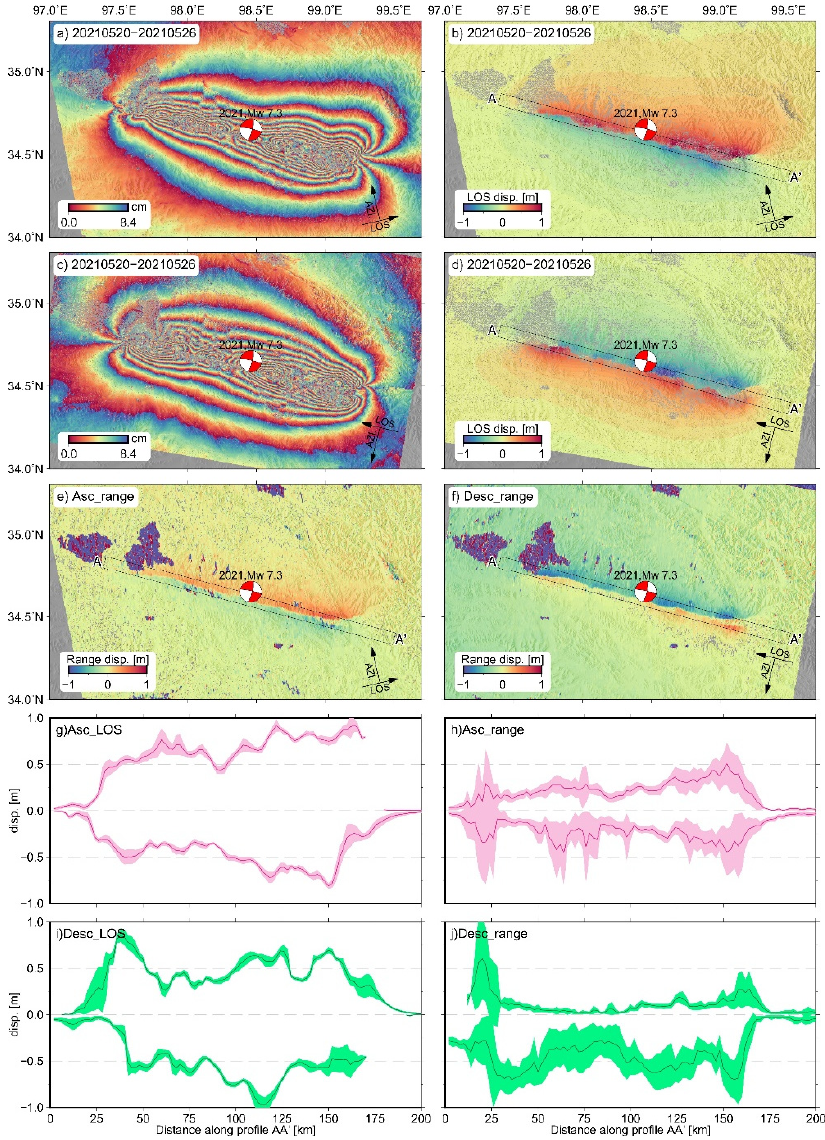
Figure 2. Interferograms and displacement fields of the 2021 Maduo earthquake. The black box (AA (cid:48) ) indicates a 200 km by 8 km profile swath. ( a , b ) Interferogram and displacement field on the ascending track. ( c , d ) Interferogram and displacement field on the descending track. ( e , f ) Ascending and descending displacement fields in ground range direction resolved by the offset tracking method. ( g , i ) Displacement profiles of LOS deformation fields. Green and red color indicate observations on the ascending and descending tracks, respectively. ( h , j ) Profiles of displacement in the ground range direction, green and red also denote observations on the ascending and descending tracks, respectively. Table 2. Focal mechanism parameters of the Maduo earthquake.